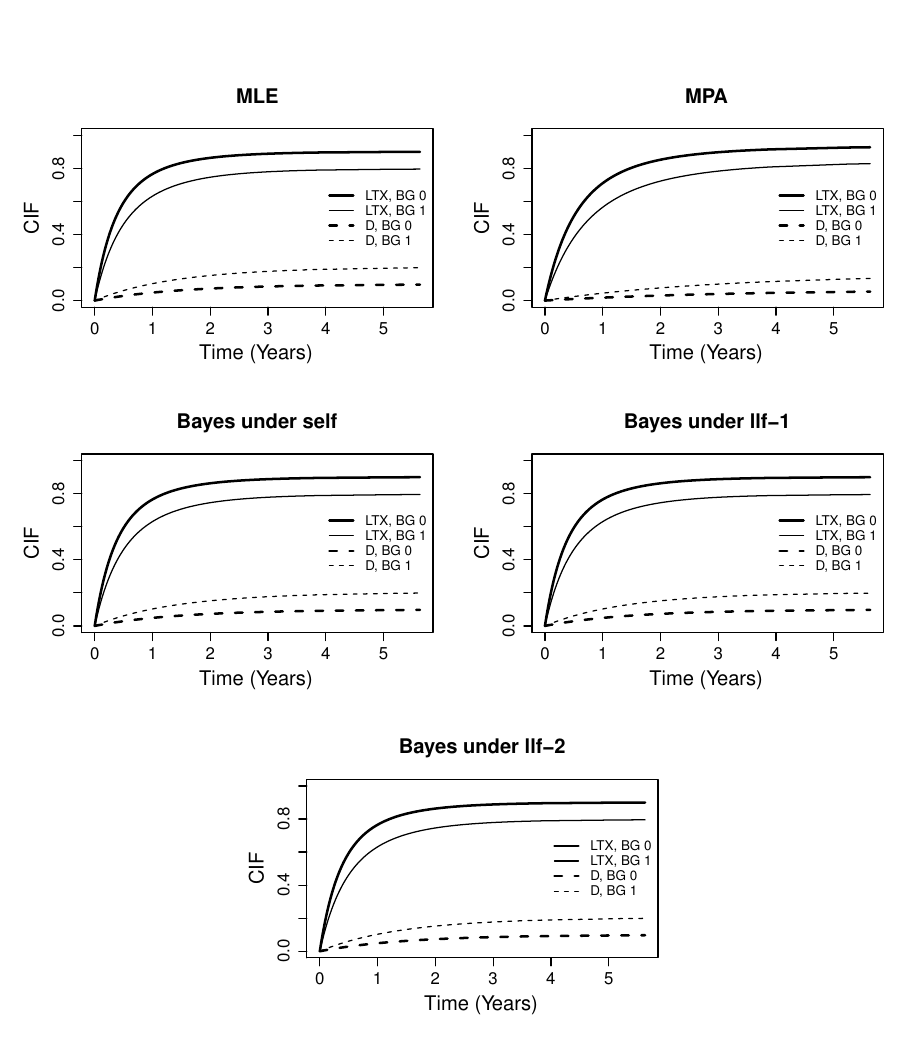
Figure 2 – Estimated CIFs of transplant (LTX) and death (D) for both the blood groups